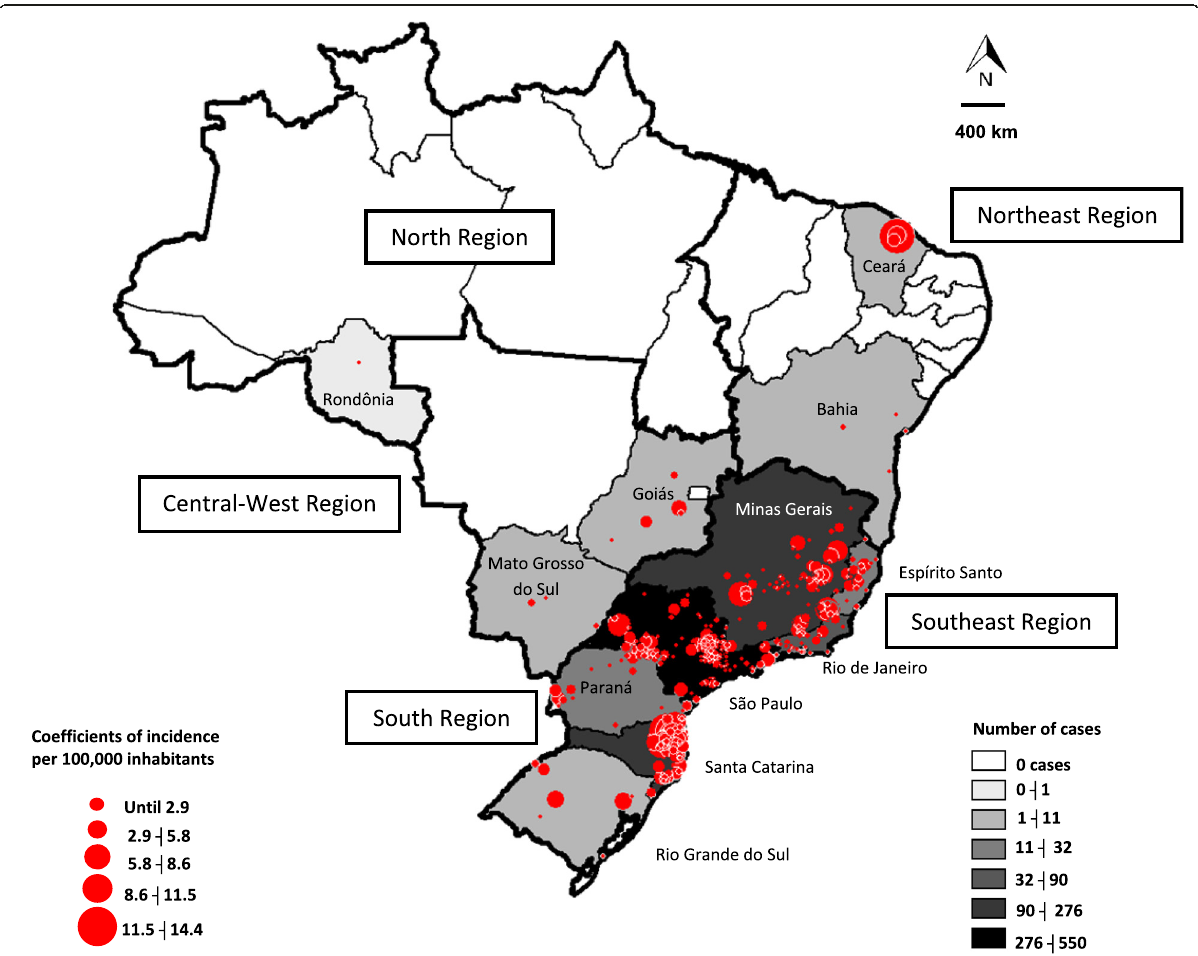
Fig. 2 Geographical distribution of confirmed cases of spotted fever by federative unit (FU) and average incidence rate in affected municipalities between 2007 and